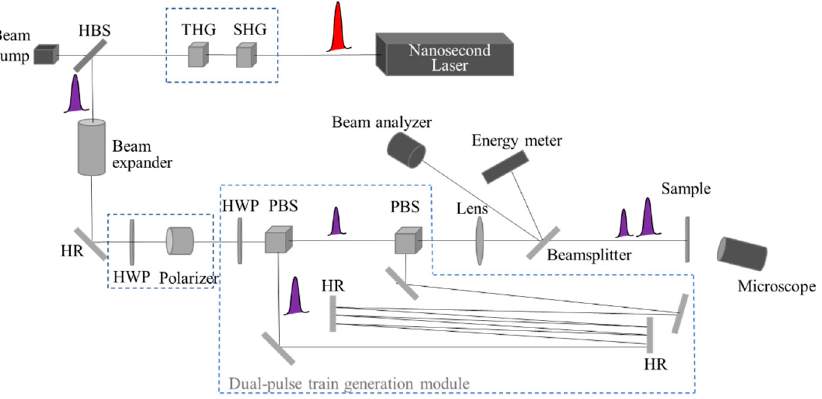
Figure 1. Schematic of nanosecond dual-pulse laser damage test setup. SHG: second harmonic generation crystal; THG: third harmonic generation crystal; HBS: harmonic beam splitters; HR: high reflectance mirror; HWP: half wave-plate; PBS: polarization beam splitter.